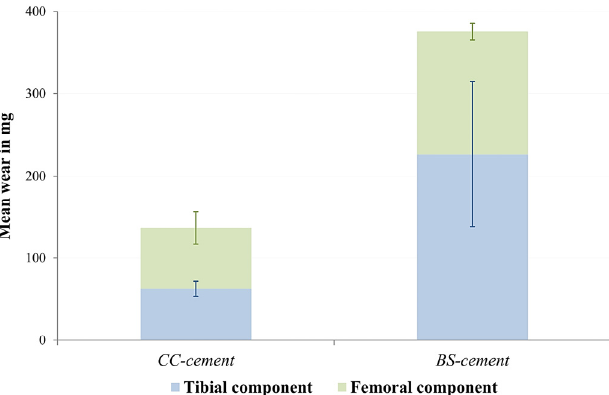
Figure 5. Comparison of the wear results of the tested femoral and tibial components of the two different cements. Error bars represent the standard error of mean.